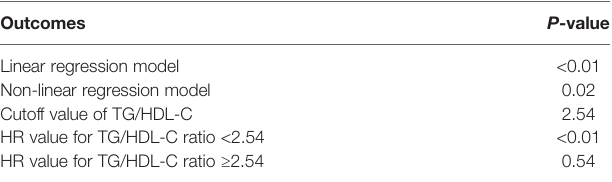
TABLE 3 | Non-linear effect of TG/HDL-C ratio in incident T2DM. Outcomes